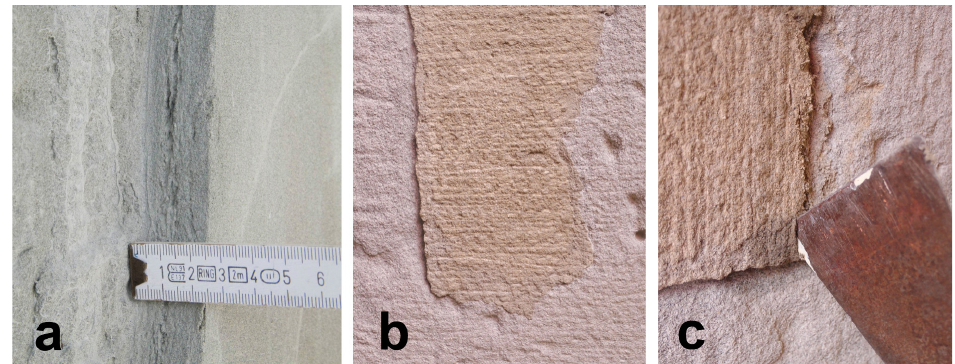
Figure 1. ( a ) Common dimension of a flake in a historical building molasse sandstone; ( b ) Old acrylic-based mortar used in Lausanne, after more than 30 years; ( c ) Reversibility of the old acrylic-based